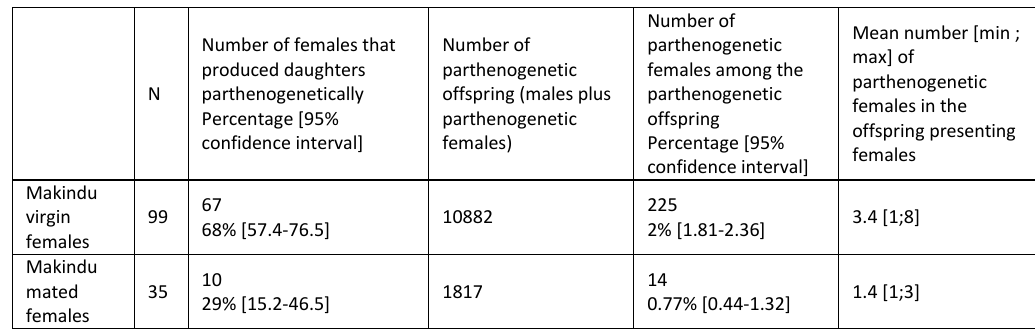
Table 4: Comparison of the frequency of the thelytokous character between virgin and mated Makindu